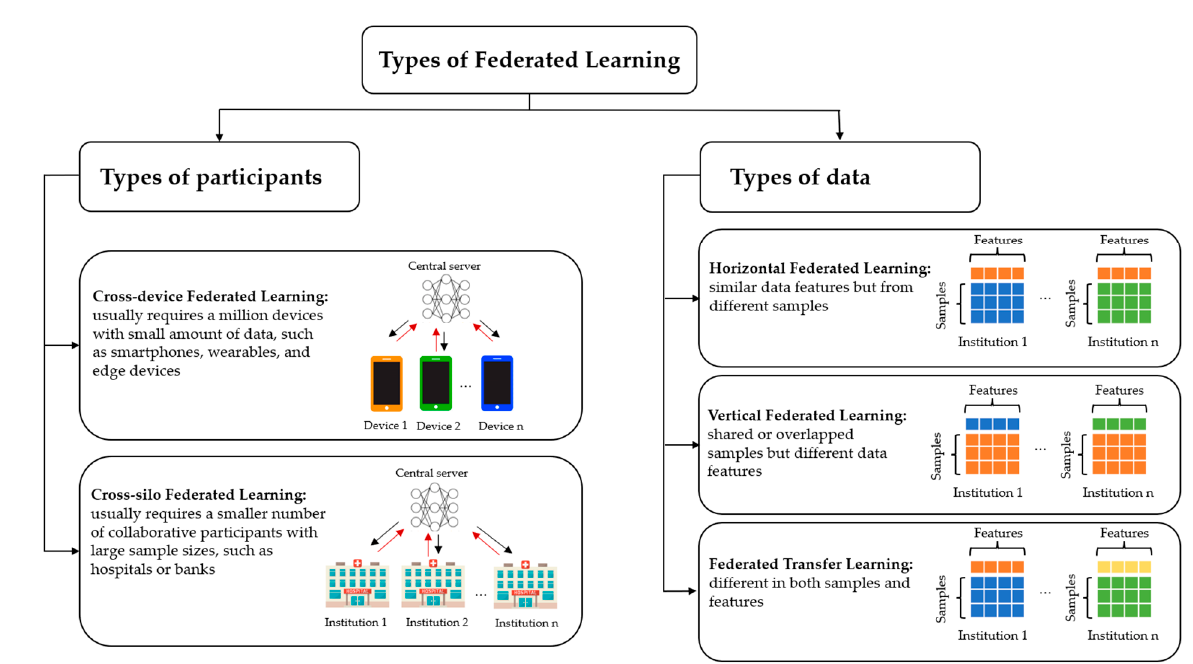
Figure 3. Types of federated learning.